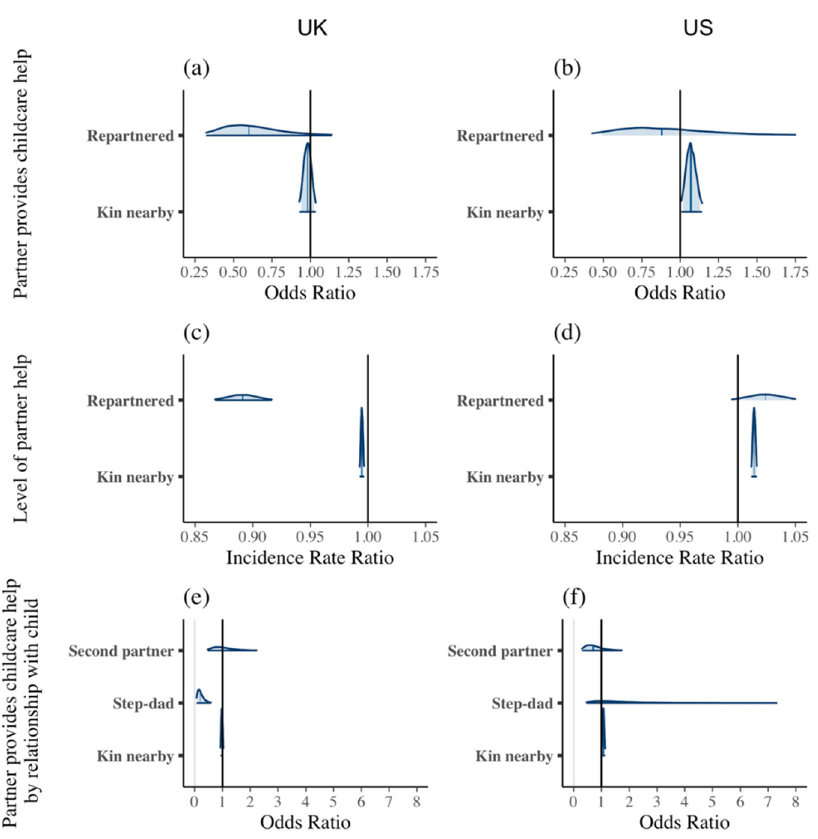
Figure 1. Plots showing the posterior distributions (95% credibility intervals) for the major predictors and control variables in the models for partner investment in each country, using the following measures: ( a , b ) likelihood of partner involvement in childcare; ( c , d ) level of childcare help from the partner; and ( e , f ) likelihood of providing childcare help based on partner’s relationship to child. Reference category for repartnered is partnered women; reference category for women with a second partner or a step-dad (second partner caring for a step-child) is women with a first partner; kin nearby is entered as a continuous